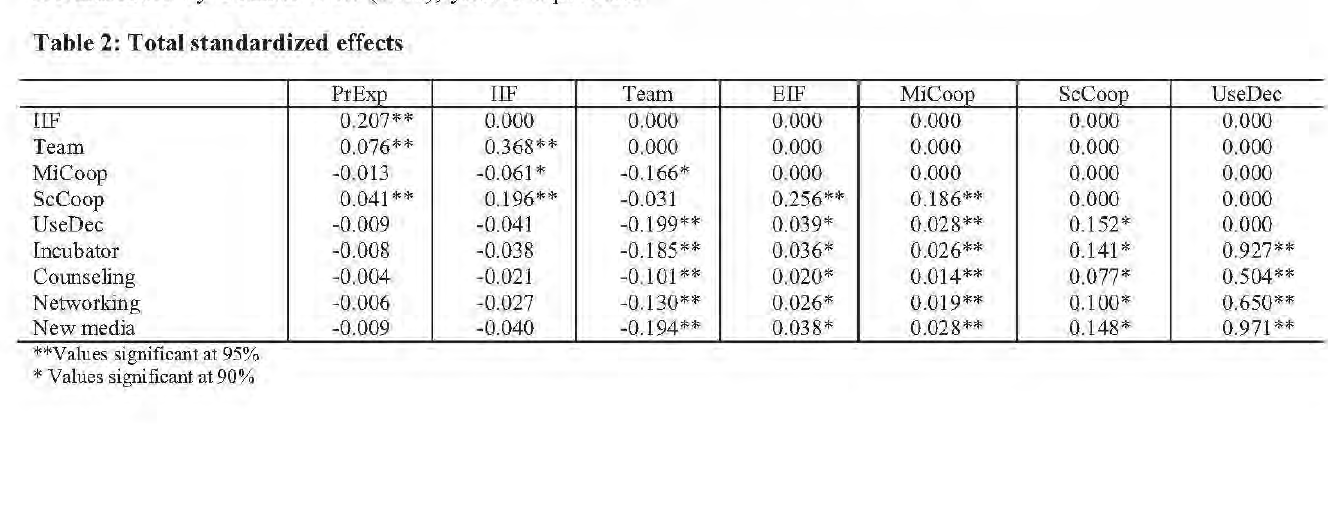
Table 2: Total standardized effects